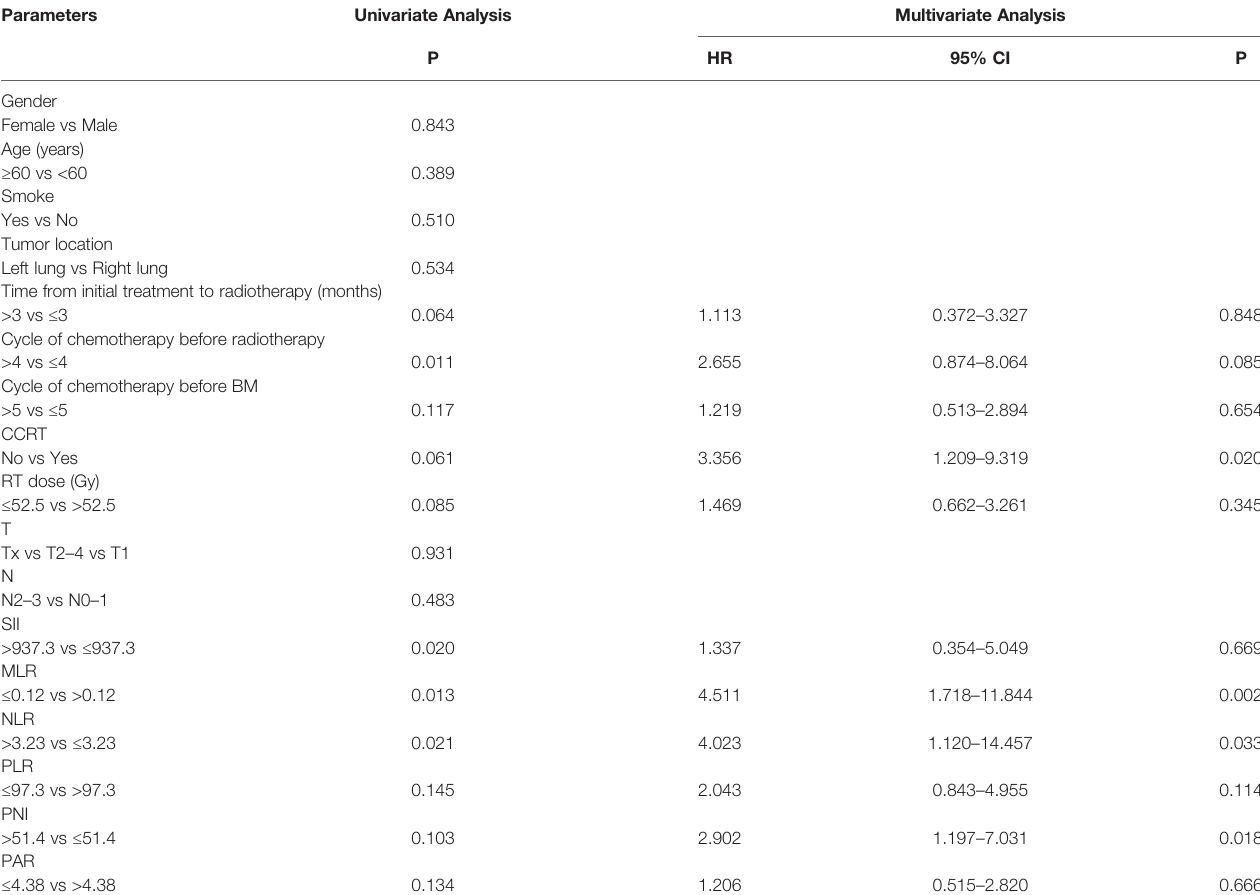
TABLE 2 | Log-rank tests and Cox regression analysis of factors associated with BMFS.